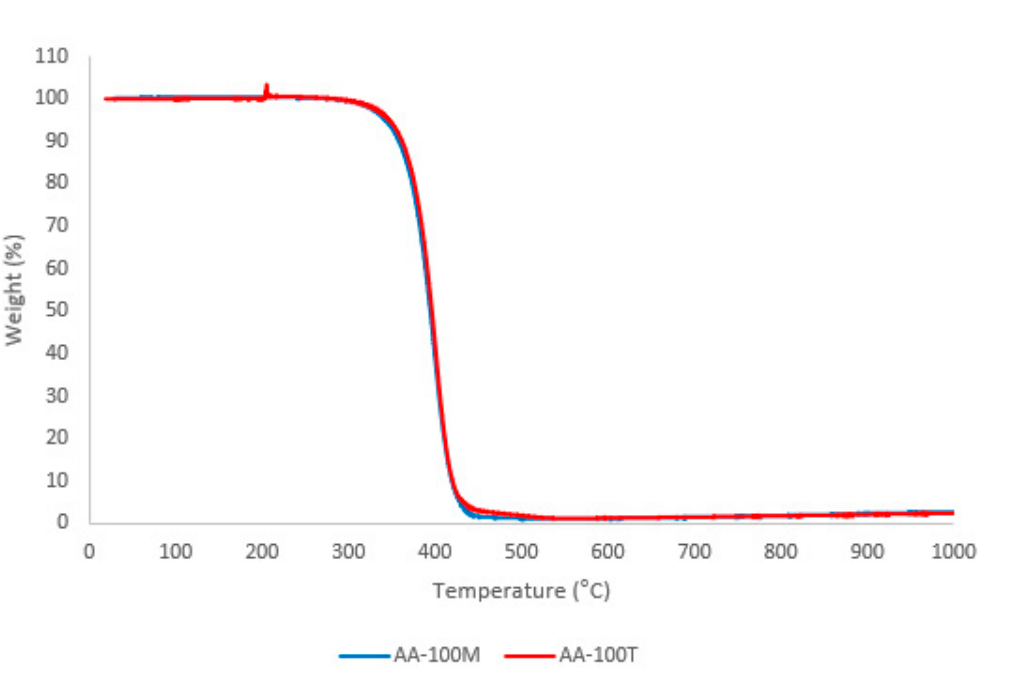
Figure 5. Comparison between TGA curves of samples AA-100M vs. AA-100T.